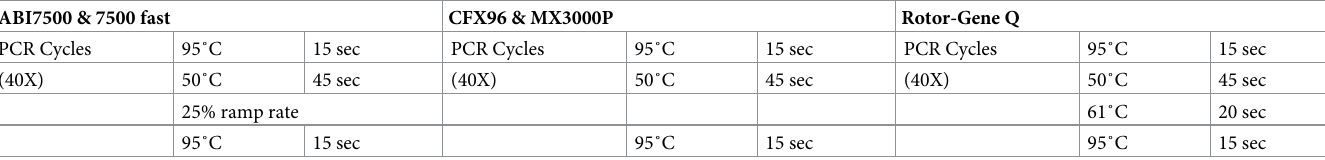
Table 2. Validated ITD 5.0 run conditions on different real time